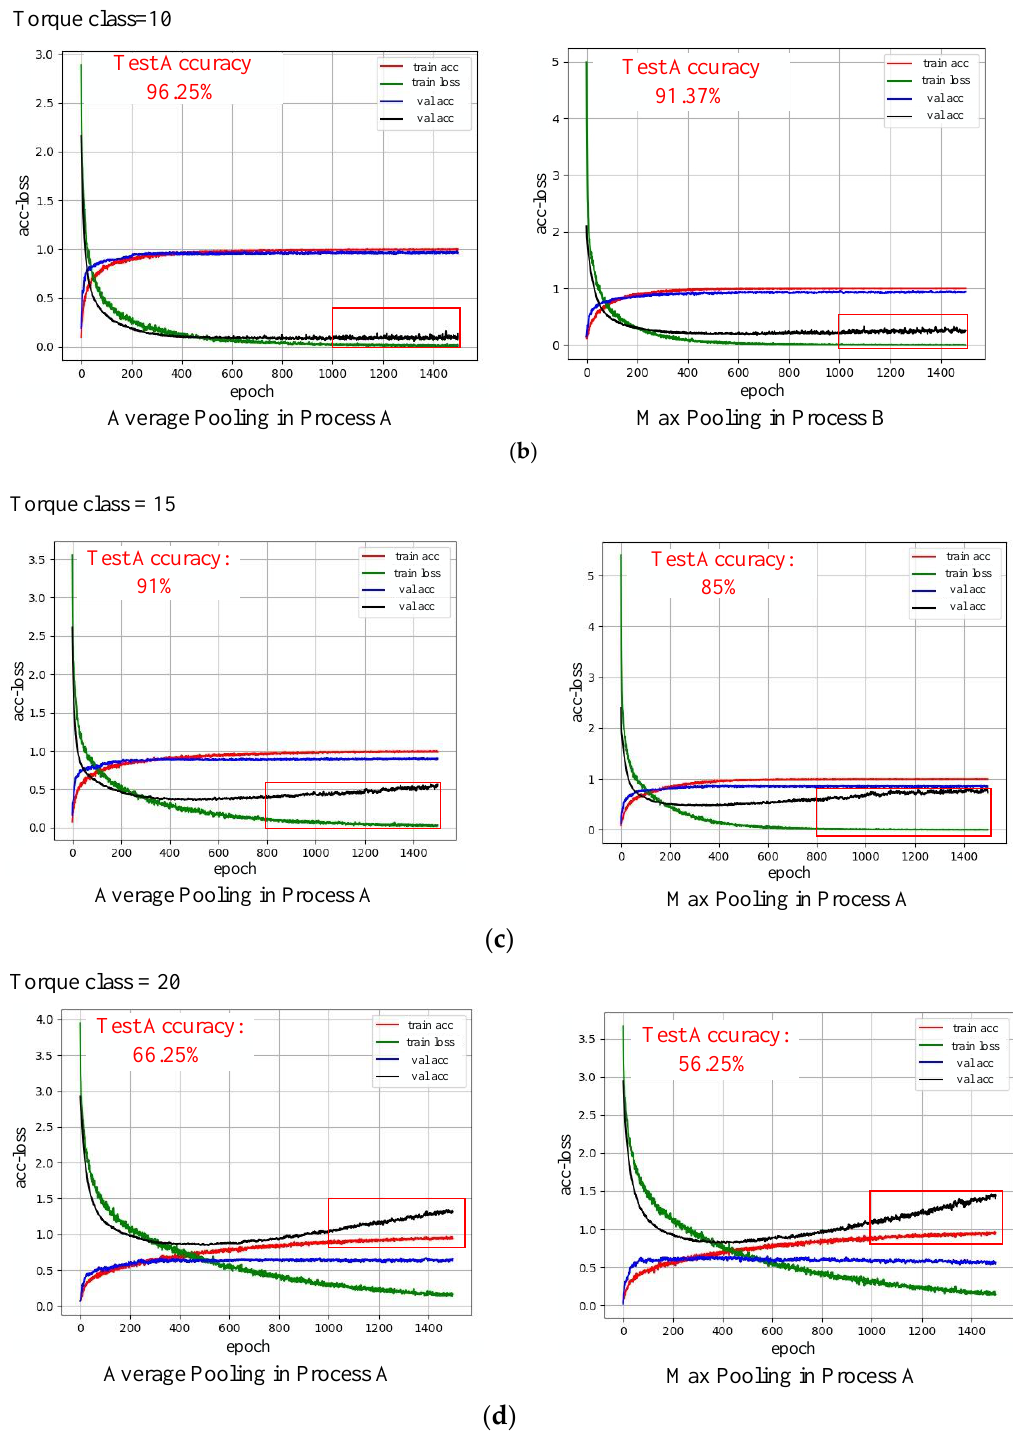
Figure 8. Effects of pooling methods on network training under various classification granularities: ( a ) 5, ( b ) 10, ( c ) 15, ( d ) 20.